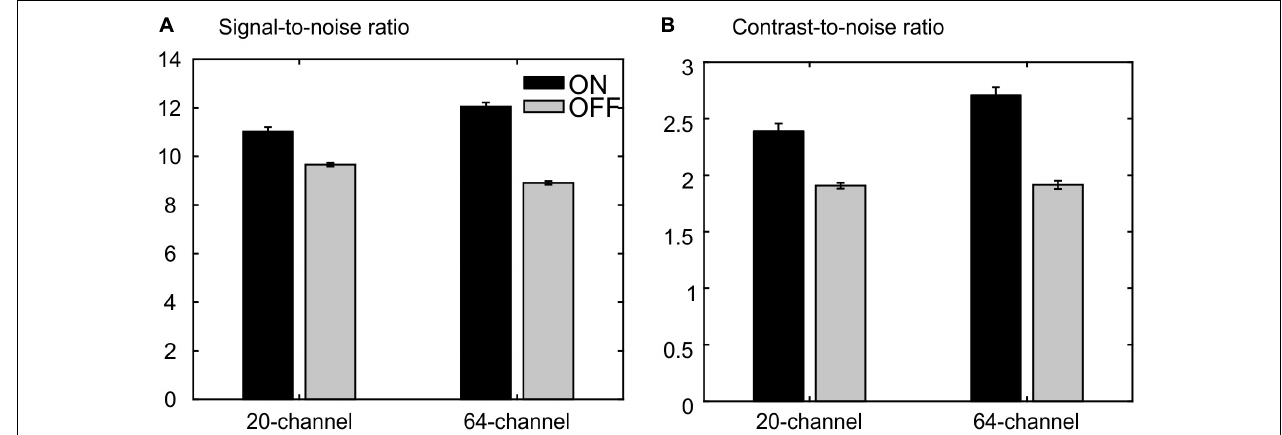
FIGURE 7 | MRIQC results for the structural data: (A) results for the analyses of the signal-to-noise ratio, larger values are better. (B) Results of analyses of the contrast-to-noise ratio; larger values are better. There is an advantage for the prescan normalize filter turned ON.